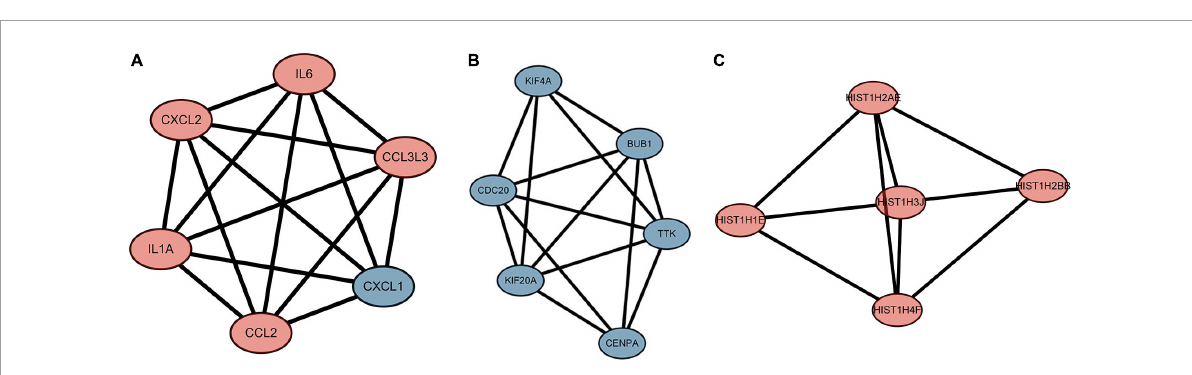
FIGURE6 The highly expressed protein-protein interaction (PPI) network. (A) Score 6, (B) Score 5.6, (C) Score 4.6. The red represents the up-regulated genes. The blue represents the down-regulated genes.